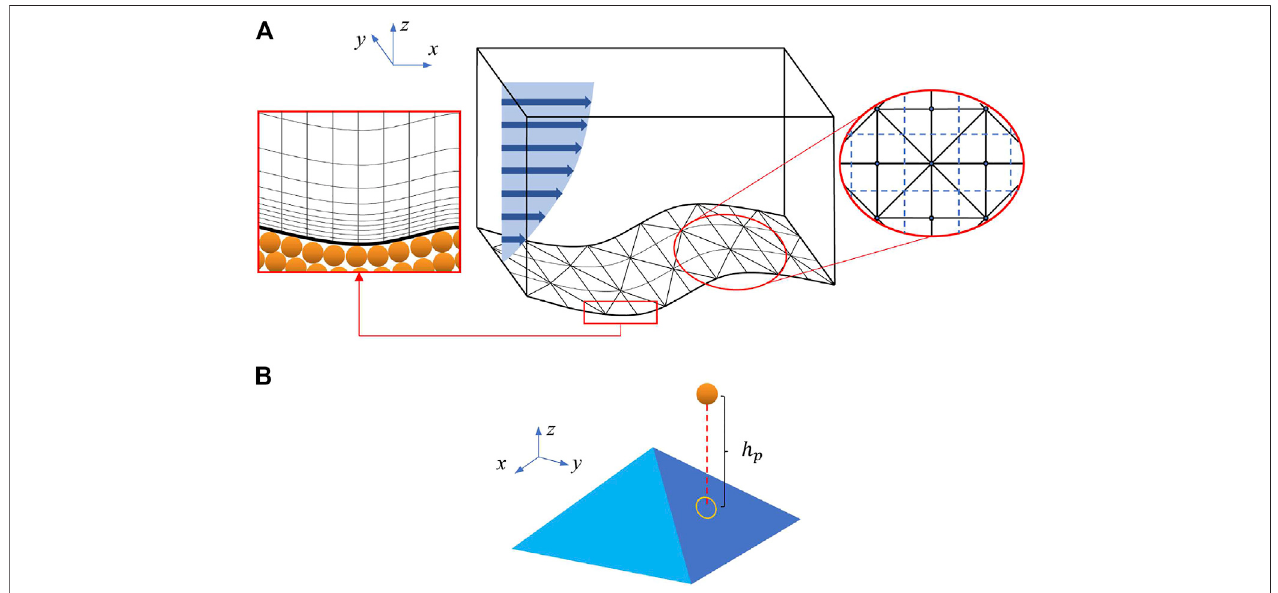
FIGURE 2 | (A) Sketch of the computational domain. The left inset shows the re fi ned grid near the bed surface. The right inset illustrates the arrangement of the surface subregion and the triangulation. (B) Sketch of a single bed surface triangulated element and the de fi nition of h p .